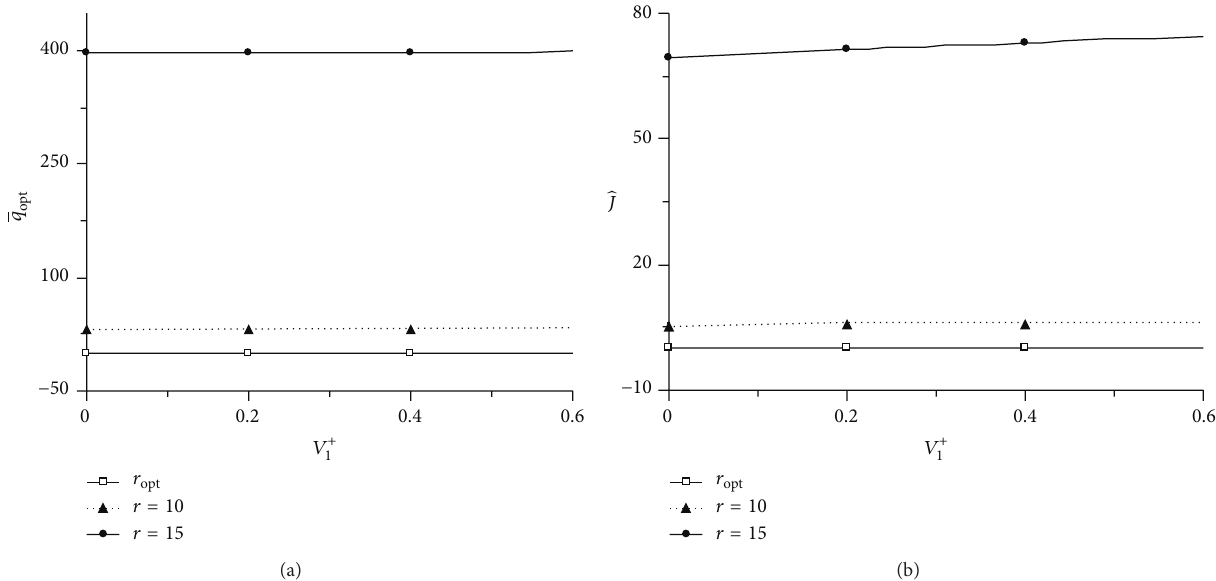
̂𝐽 and the energy for SSSS plates with 𝑝 = 4 opt